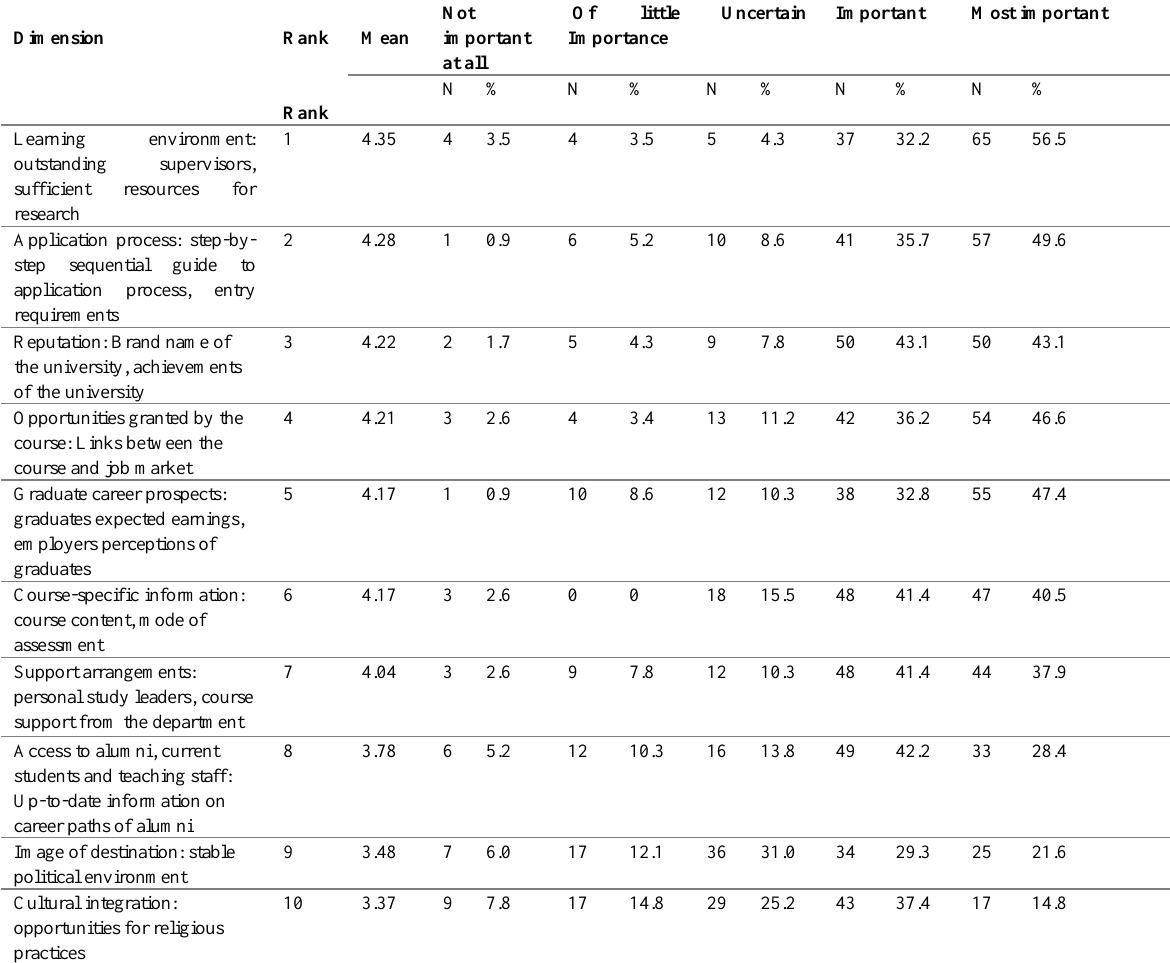
Table 2: Information needs of postgraduate